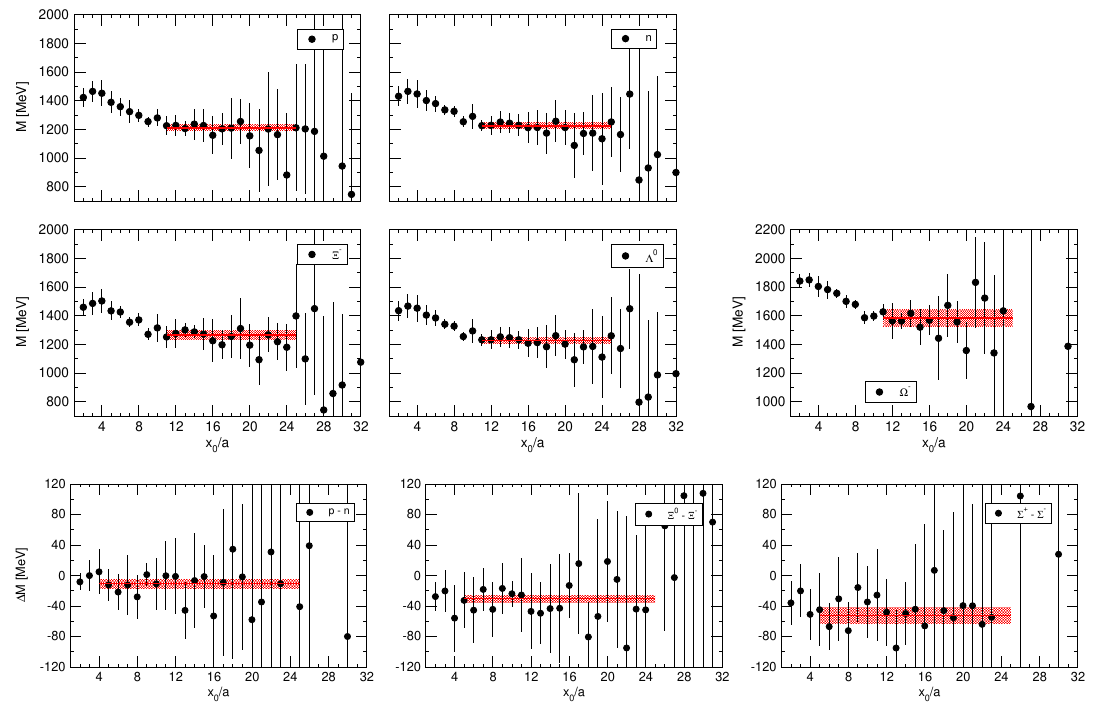
Figure 7 . Baryon effective masses and effective φ observables for the ensemble A360a50b324+RW2 , with the selected plateaux and the fits to a constant. Values in MeV are obtained by using the reference value (8 t 0 ) 1 / 2 = 0 . 415